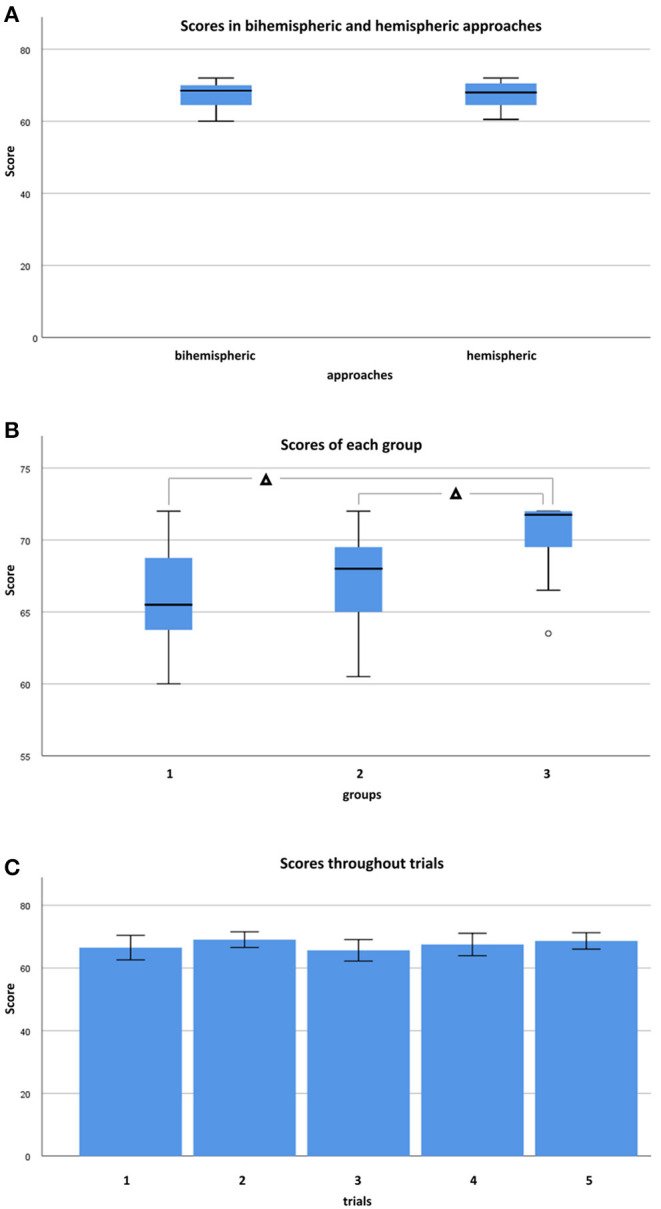
Demonstrates confrontation of scores in box and whisker plots between bihemispheric and hemispheric approaches, levels, and trials. (A) Scores in bihemispheric (n = 33) and hemispheric (n = 22) tailored brains throughout groups. Mann-Whitney-U-test found no statistically significant difference between bihemispheric and hemispheric approaches if considered for all groups (p = 0.776). (B) Scores throughout approaches and trials of each group. Experienced raters scored higher than less experienced raters (One-way ANOVA, post-hoc Dunnett-T) if group III (n = 10) and II (n = 25), as well as group III (n = 10) and group I (n = 20) were compared to each other (p < 0.05), but not (p = 0.429) if comparison was performed between group II (n = 25) and group I (n = 20). (C) Almost consistent scores from trials 1 (n = 11) to 5 (n = 11) without significant differences among skill groups (Kendall-Tau-b = 0.074, p = 0.470). °Indicates individual Outliers. Significant differences are indicated with Δ for p < 0.05.